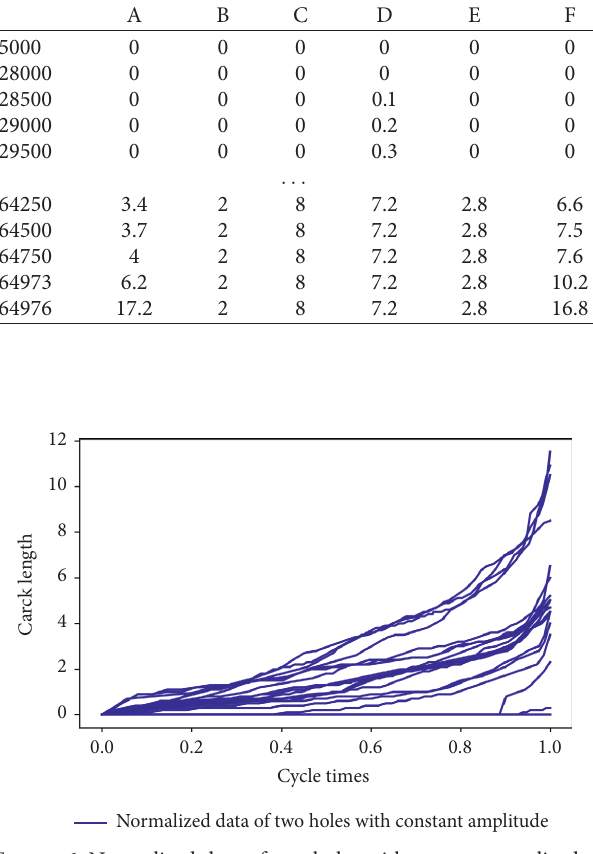
Figure 6: Normalized data of two holes with constant